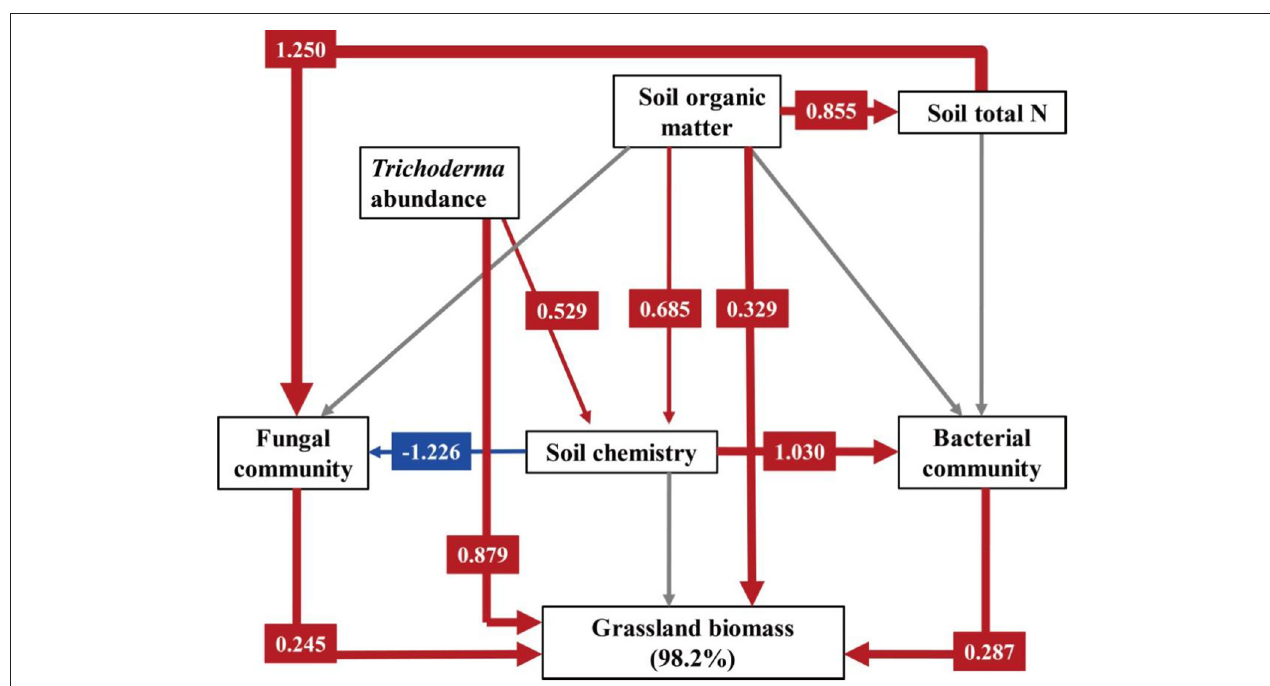
FIGURE 5 | Structural equation modeling (SEM) for grassland biomass. Numbers following variables show the percentage of its variance explained by its predictors. We utilized PCA to demonstrate variations in fungal community across different treatments, and PC1 was selected as the parameter describing the fungal community (PC1 explained 87.25% of total variation in the fungal community). Similarly, PC1 explained 44.85 and 62.77% of total variation in the bacterial community and the soil chemistry, respectively. A path coefficient is analogous to a partial correlation coefficient and describes the strength and sign of the relationship between two variables. Negative pathways are shown as blue lines, positive pathways are shown as red lines, and line thickness represents the intensity of influence. Non-significant pathways are shown in gray. Models are a good fit of our data. Model fits are given in Table S3, and significance levels are provided in Table S4.